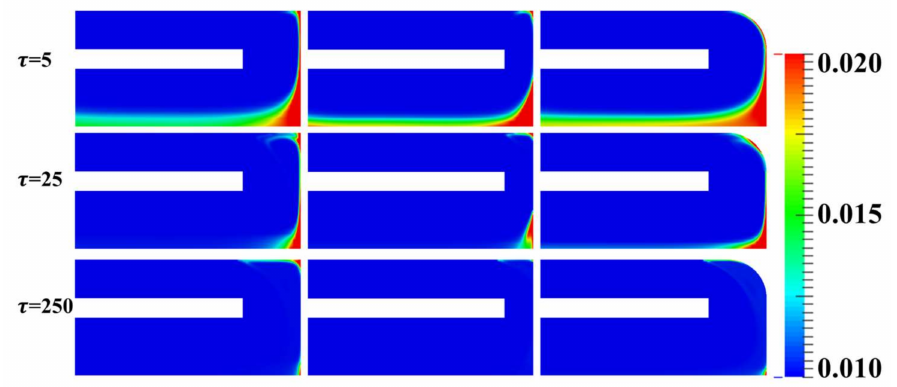
Figure 14. Nanoparticle concentration field at different times for different bottom borehole geometries: ( left ) The distance between the end of the inner pipe and the bottom borehole is H = r 1 ; ( middle ) The distance between the end of the inner pipe and the bottom borehole is H = r 1 /2; and ( right ) Rounded bottom with H = r 1 . The Reynolds number is